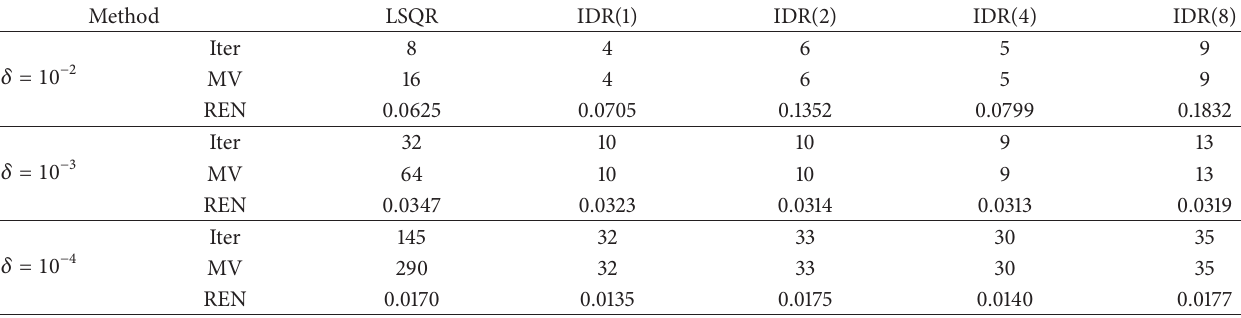
Table 1: Image deblurring using LSQR and IDR( 𝑠 ) for “Lena” ( 𝜎 = 1 ).